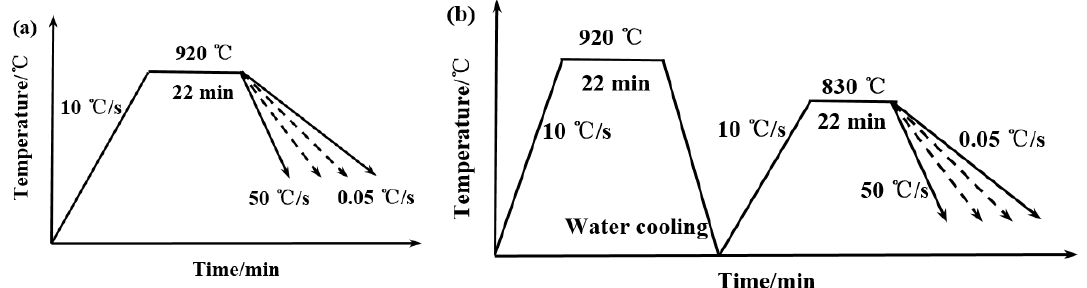
Figure 3. Process diagram ( a ) first group test; ( b ) second group test.